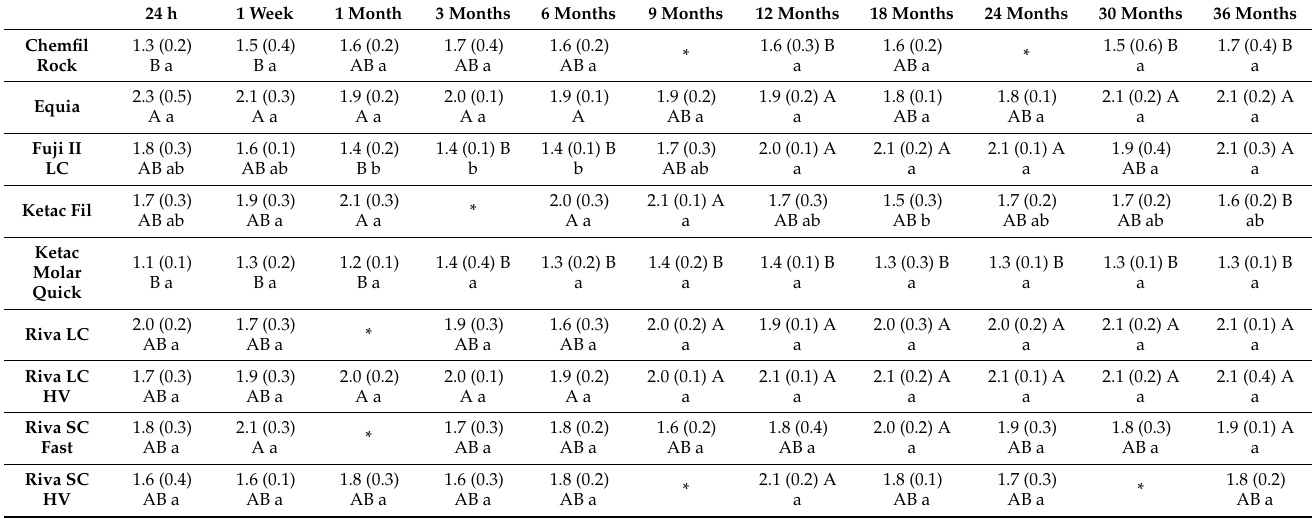
Table 4. Mean Bound Water Loss (%).